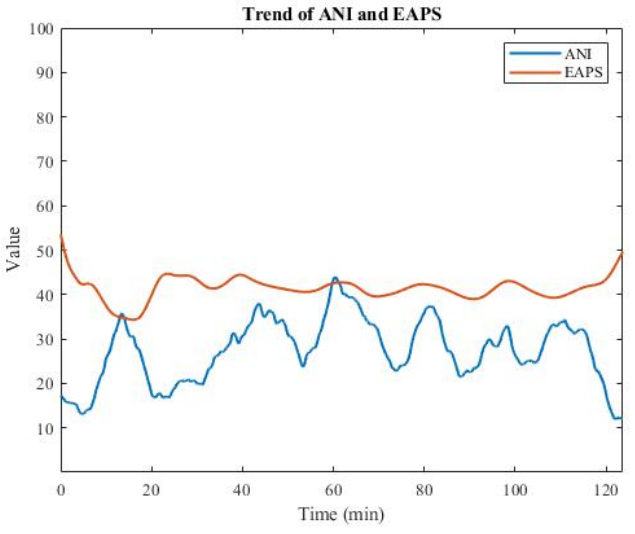
Figure 5. Plot of ANI along with EAPS.